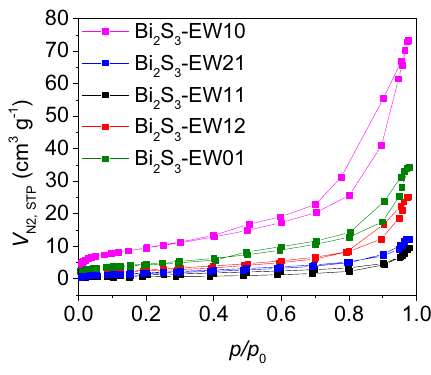
Fig. 3 Isotherms adsorption/desorption at 77 K for bismuth sulfides